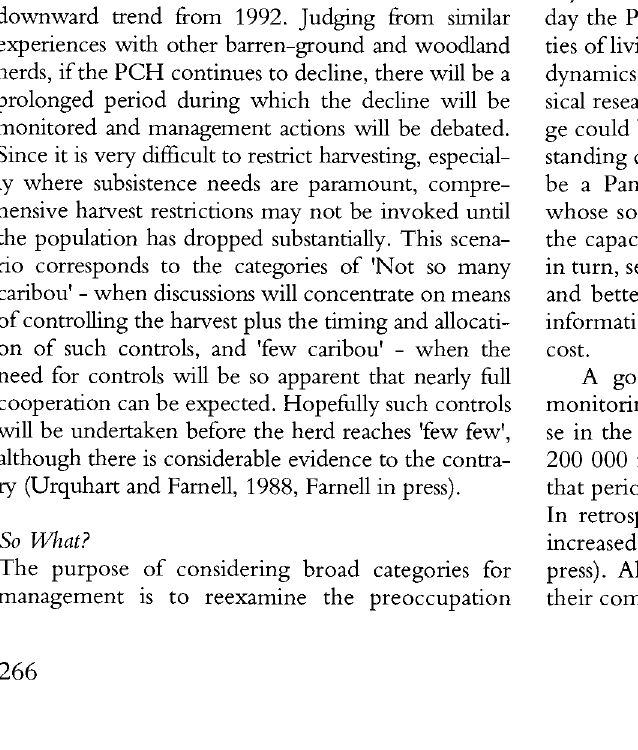
Fig. 2. Possible management responses to various catego ries of P CH population status in the